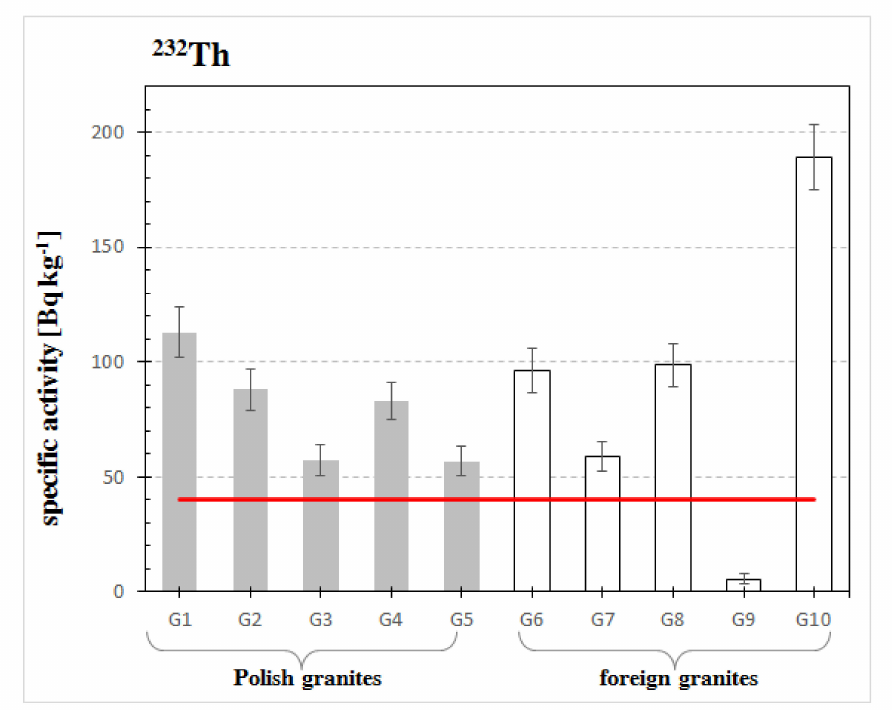
Figure 5. Specific activity of thorium 232 Th in analyzed samples of granites. The horizontal line indicates the average specific activity of 232 Th of building materials recommended by the European Commission in the Report [25] of 40 Bq · kg − 1